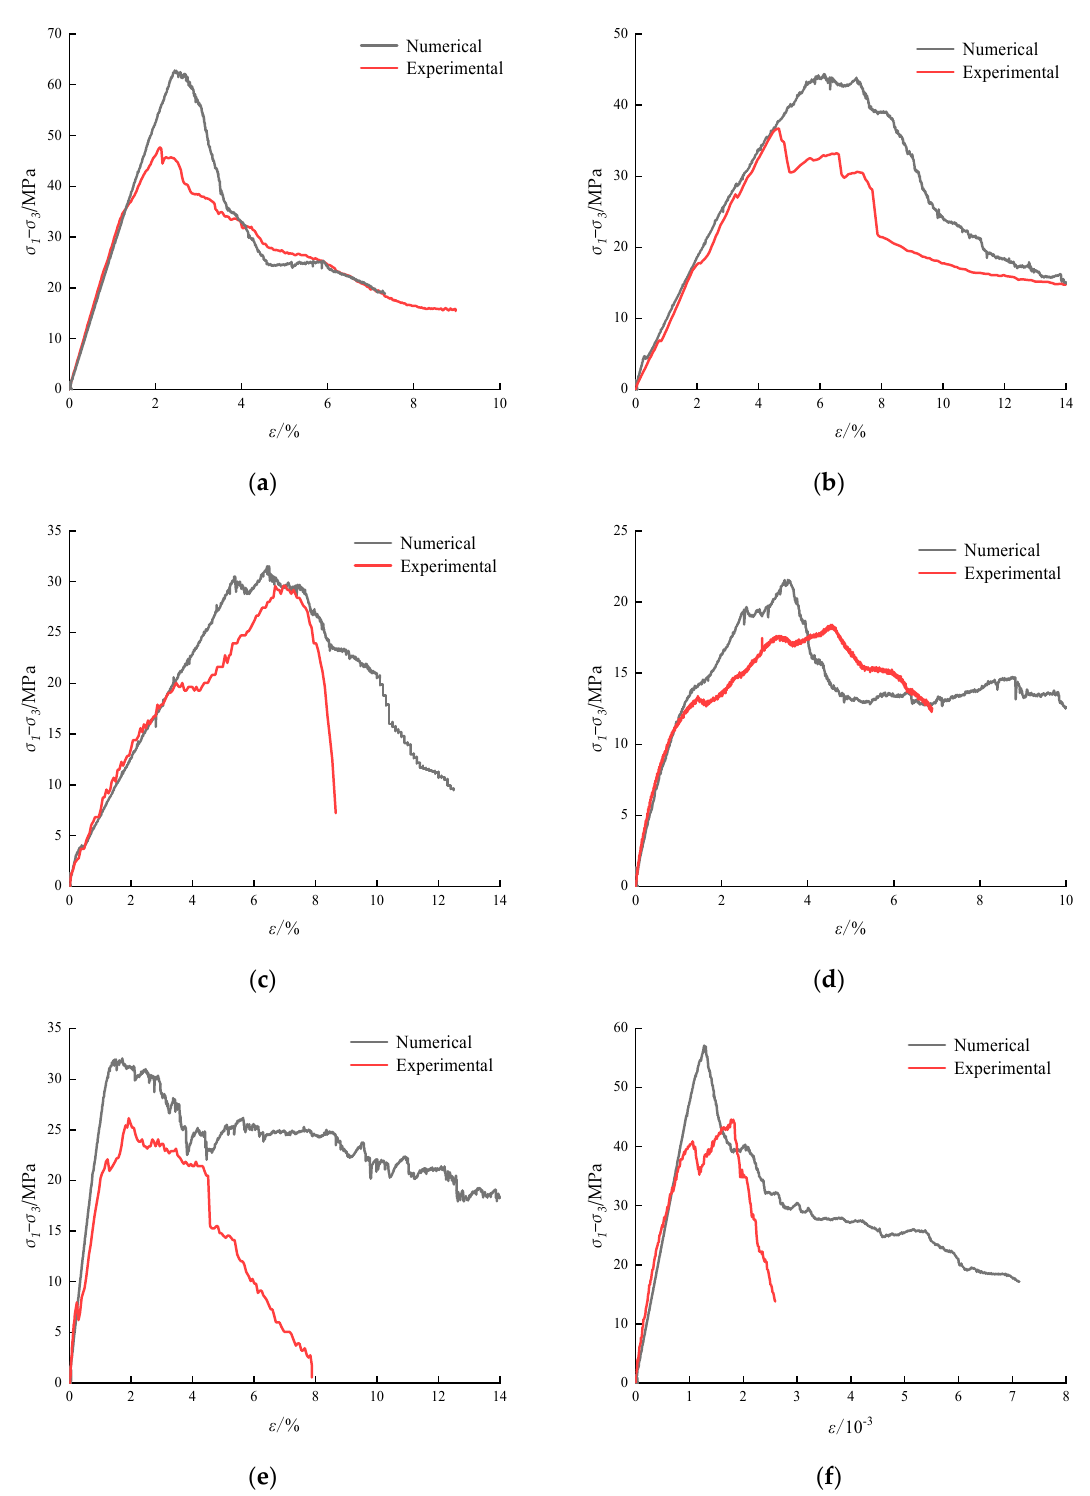
Figure 14. Deviatoric stress–strain curves of coal with different bedding angles in the numerical simulation and laboratory test. ( a ) 0°. ( b ) 30°. ( c ) 45°. ( d ) 60°. ( e ) 75°. ( f ) 90°.